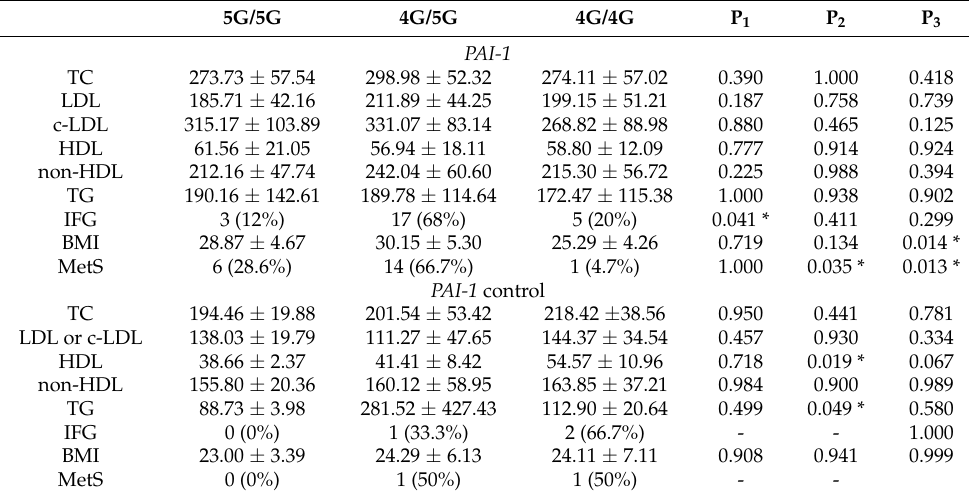
Table 3. Correlation between PAI 1 4G/5G polymorphism and metabolic